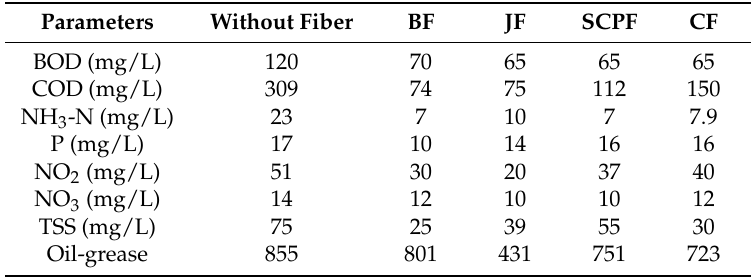
Table 5. Summary of final effluents of all parameters for all